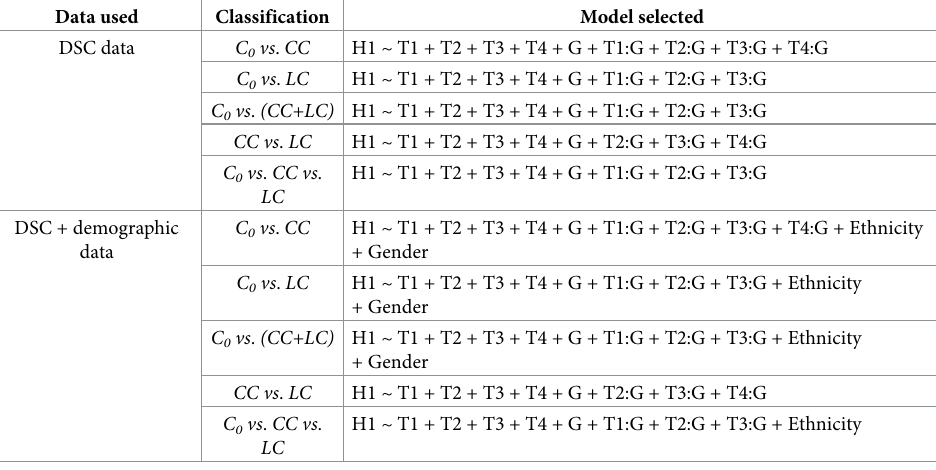
Table 3. Transformation and model selected for different